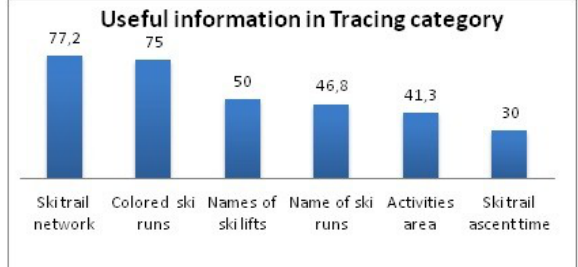
Figure 13 Percent of responses “very useful” tracing information depicted in the ski map.